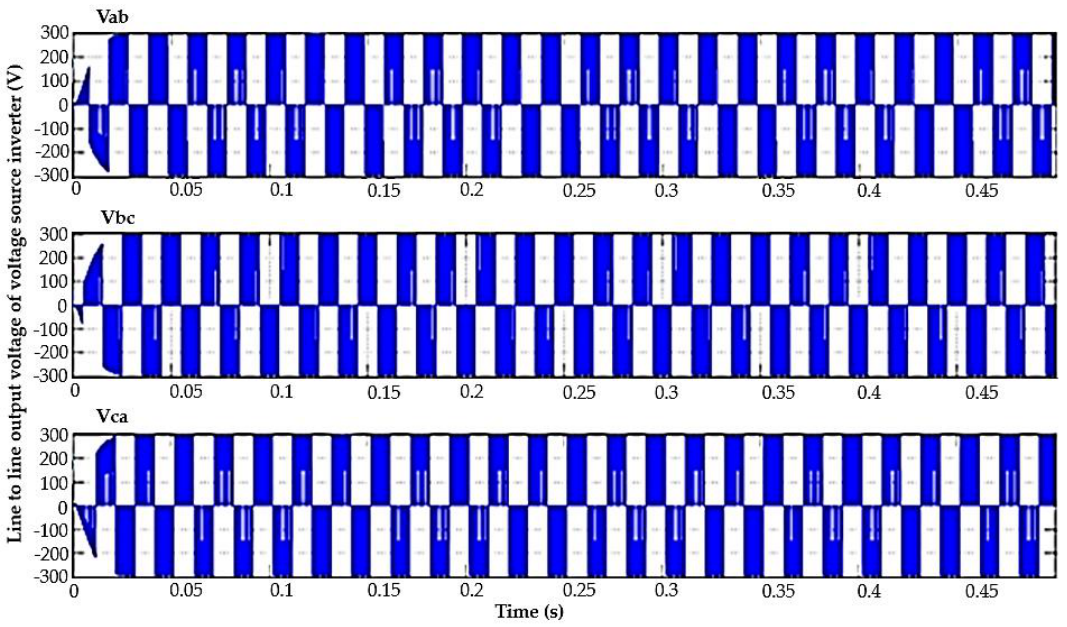
Figure 7. The output waveform of the voltage source inverter.